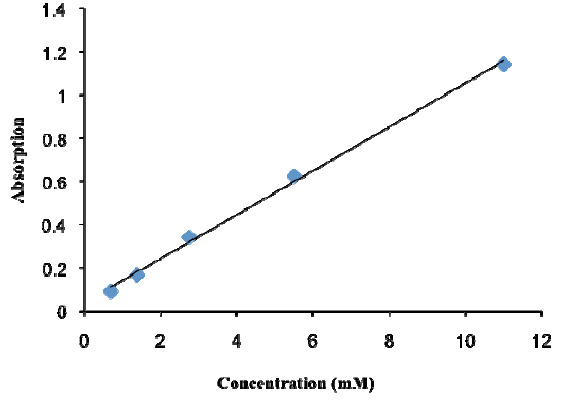
Table 1. Phosphorylation of the Wang